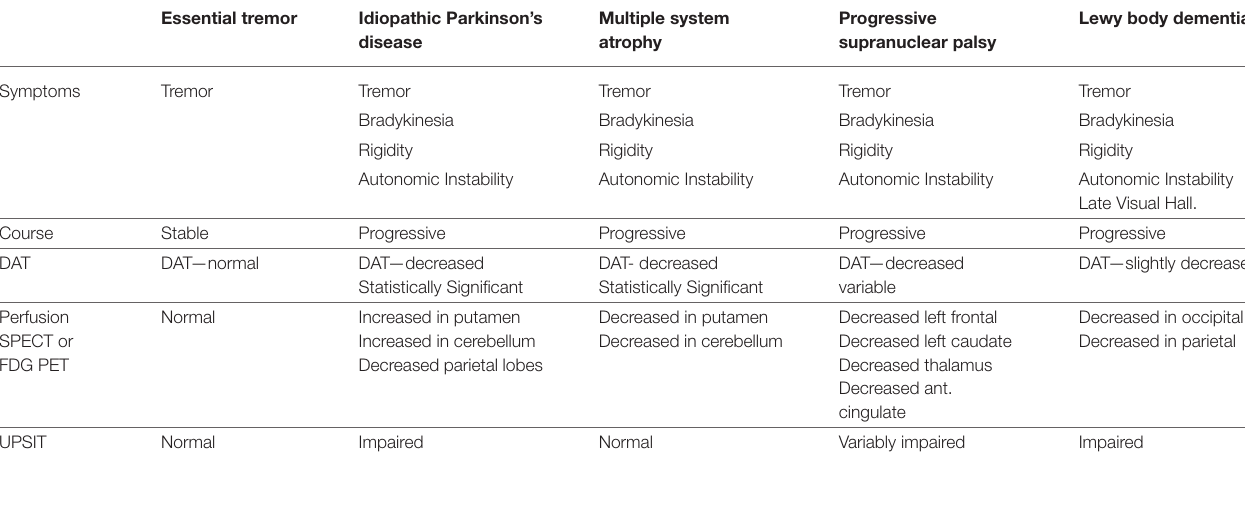
TABLE 1 | The role of functional neuroimaging in the differential diagnosis of Parkinsonian